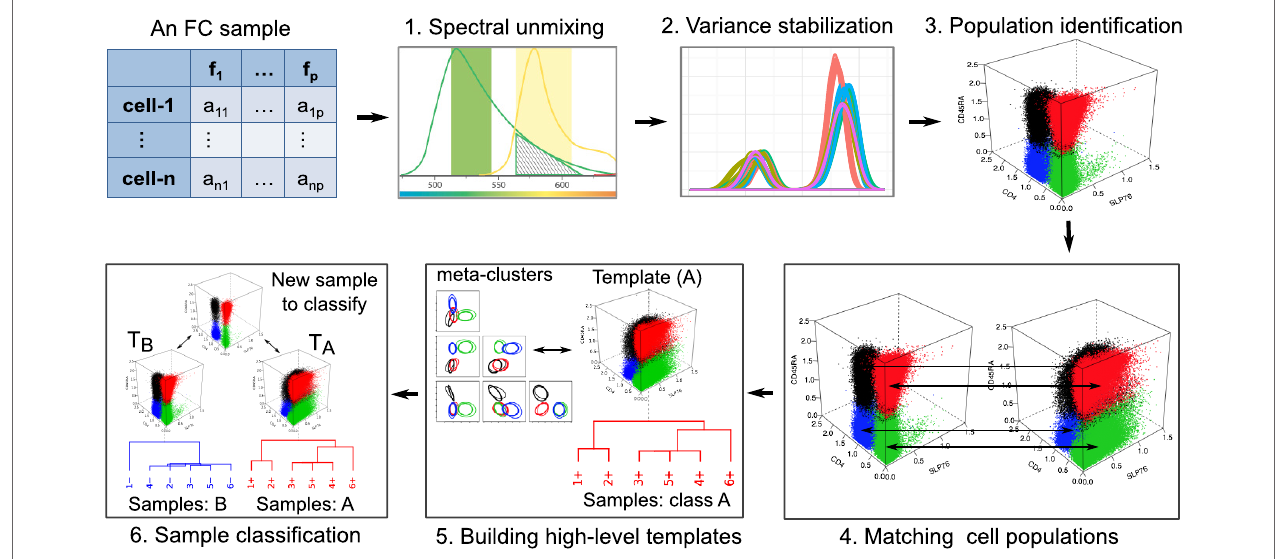
FigUre 1 | in our view, six major steps are involved in the Fc data analysis . An FC sample is represented by an n × p matrix, where n is the number of cells and p is the number of features measured in each cell. (1) The overlap of two spectra (green and yellow) emitted by two fluorochromes, which must be unmixed to correctly reconstruct the signals. (2) The density plots of a marker from several samples of a dataset after transforming data to stabilize the variance. (3) Four cell populations (marked with different colors) identified by a clustering algorithm. (4) Matching population to register corresponding cell clusters across a pair of samples. (5) The hierarchical construction of a template from six samples belonging to the same class. (6) Classifying a sample based on its similarity with two